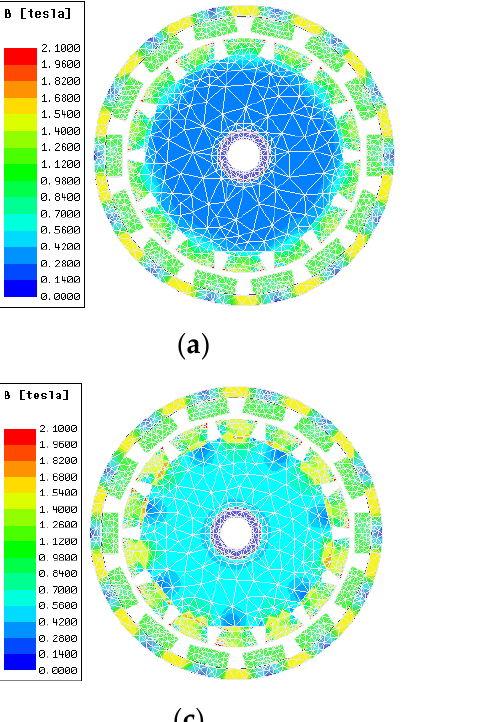
Figure 27. Diagram of the effect of axial displacement on the output electromagnetic torque. During the measurement of the actual rotation angle, a sinusoidal signal is fed to the prototype coil through a signal generator. The Hall sensor measures the angular displace- ment in real time during the rotor rotation of the prototype. The input and output signals from the oscilloscope are analyzed to obtain the relationship between the actual rotation angle of the prototype and the MMF of the coil, as shown in Figure 28. By comparing the simulated data with the experimental results, it can be found that the simulated data and the experimental results are in high agreement when the MMF is small; as the MMF grows, the error between the experimental results and the simulated data gradually increases. This is because the permeability of the actual material is lower than that of the ideal material in the simulation. From Figure 28, it can be seen that when MMF is in the range of − 40 A to 40 A, there is good linearity between the actual rotation angle of the prototype and MMF. The actual rotation angle of the rotor is 1.405° when MMF is 40 A and 1.589° when MMF is − 40 A. The asymmetry of the actual rotation angle is due to the error in the prototype machining and assembly process, which leads to the unequal spacing between the jaw pole teeth.